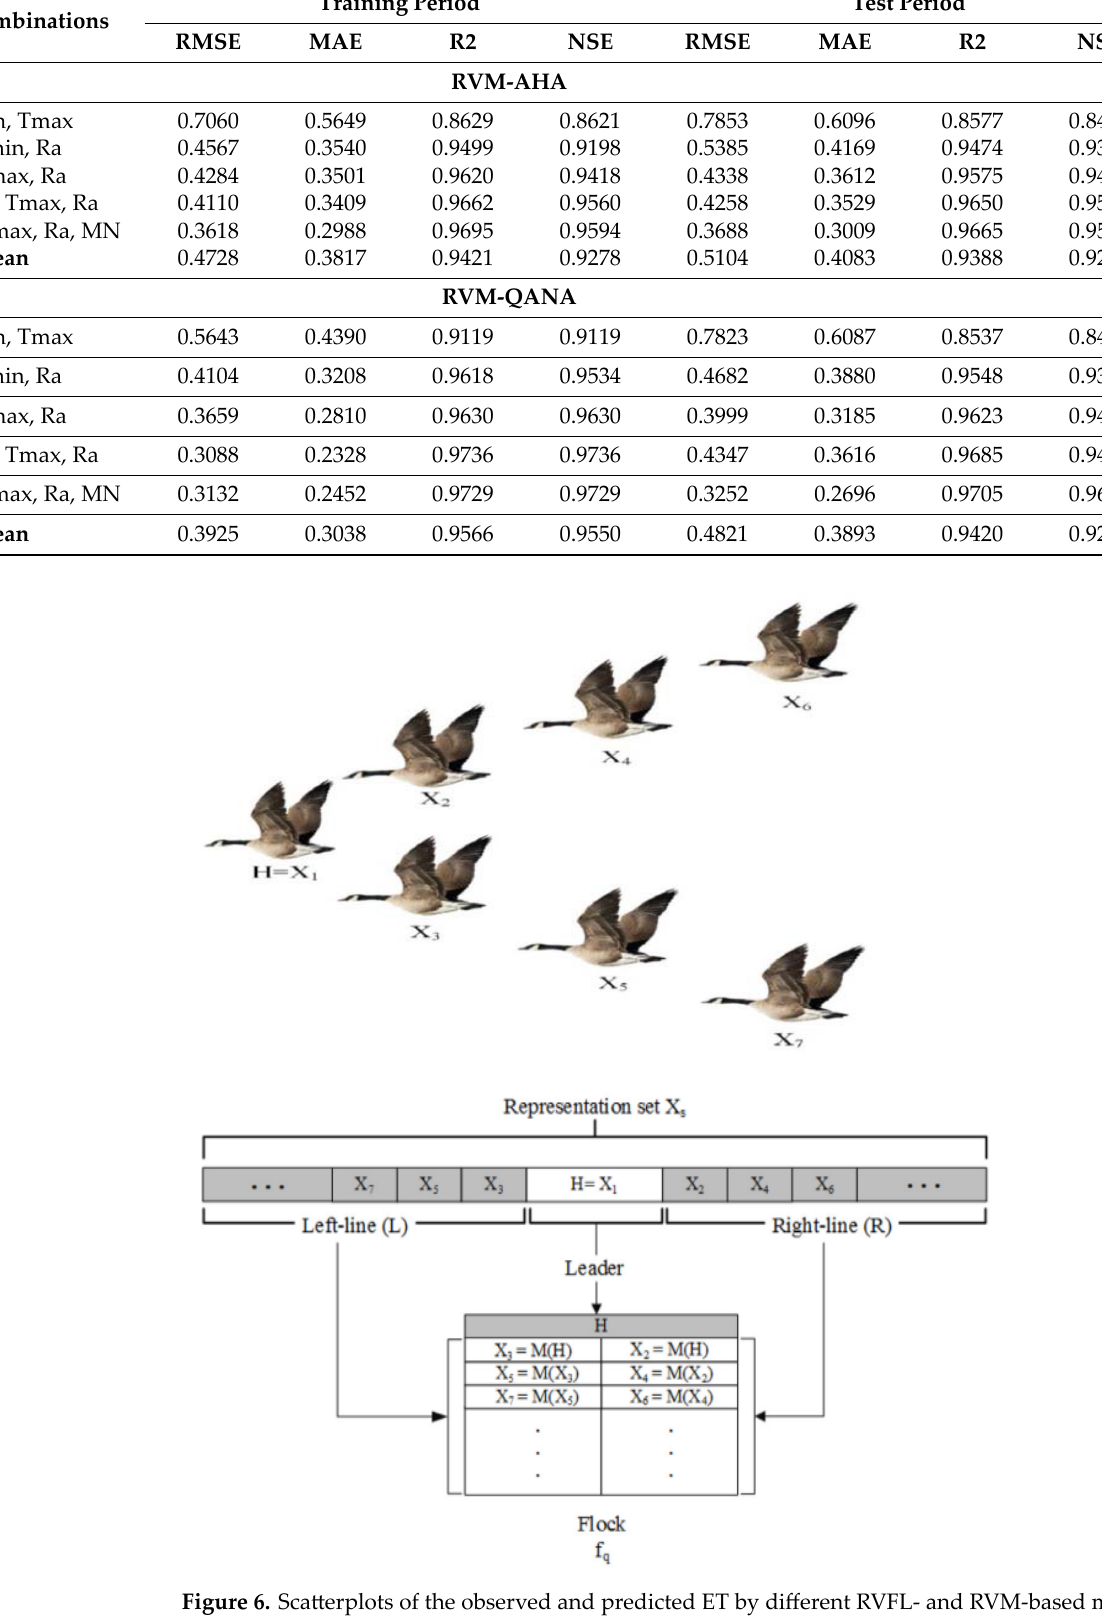
Figure 6. Scatterplots of the observed and predicted ET by different RVFL‑ and RVM‑based models Figure 6 . V ‐ echelon communication topology (a) Right ‐ line (R) and left ‐ line (L) sub ‐ in the test period using the best input combination –Station 1 sets of the V ‐ shaped structure, which also includes a header (H) (L), (b) The schematic structure of V ‐ echelon topology [33].